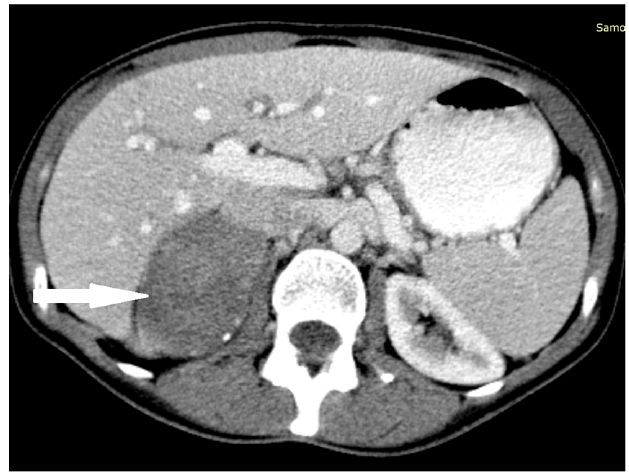
Figure 10. Ganglioneuroma. Abdomen CT, transverse cross-section.